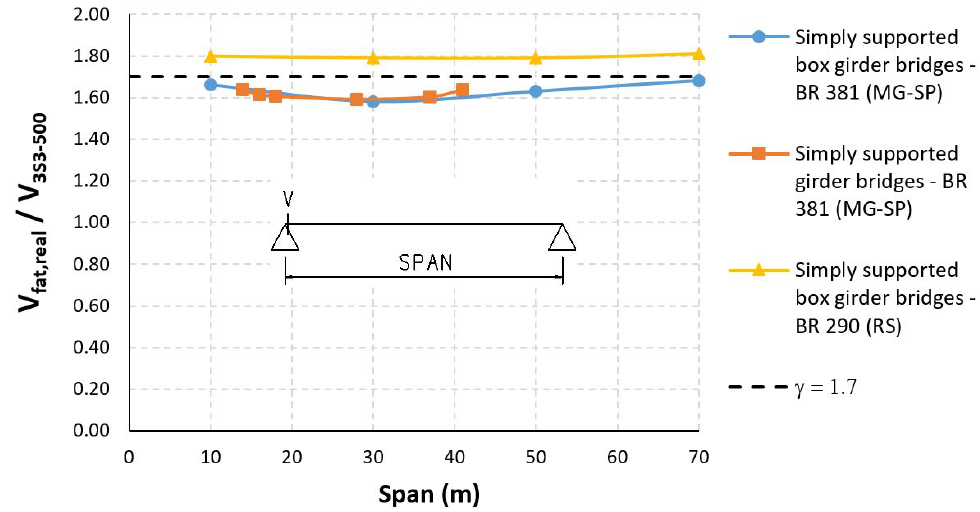
Figure 23. Bias factors for shear force related to the proposed model.